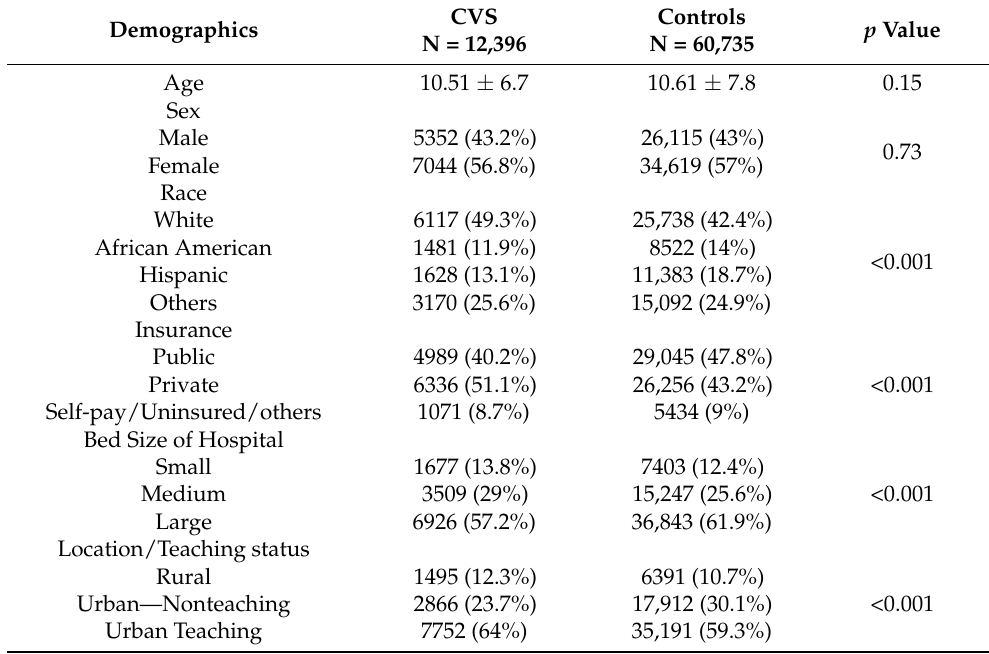
Table 1. Comparison of demographics and clinical characteristics of the CVS and non-CVS